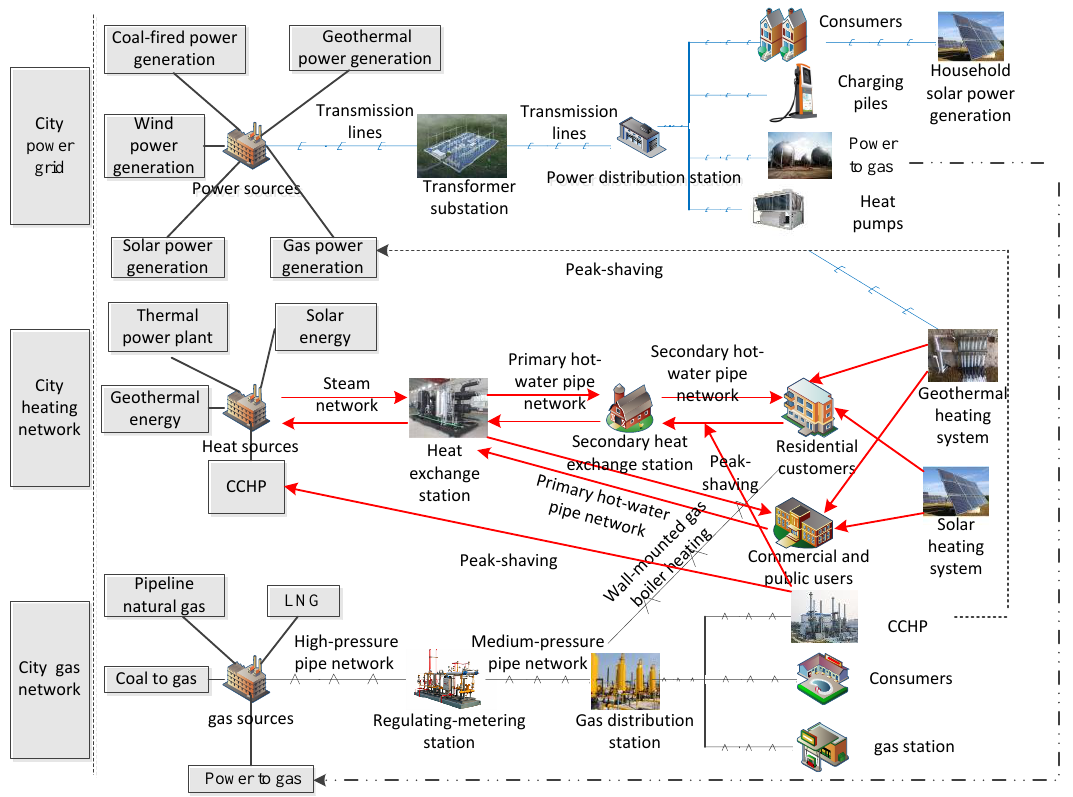
Figure 1. Sketch of urban integrated energy system comprised of electricity, heat, and gas (CCHP: combined cooling heating and power, LNG: liquefied natural gas).